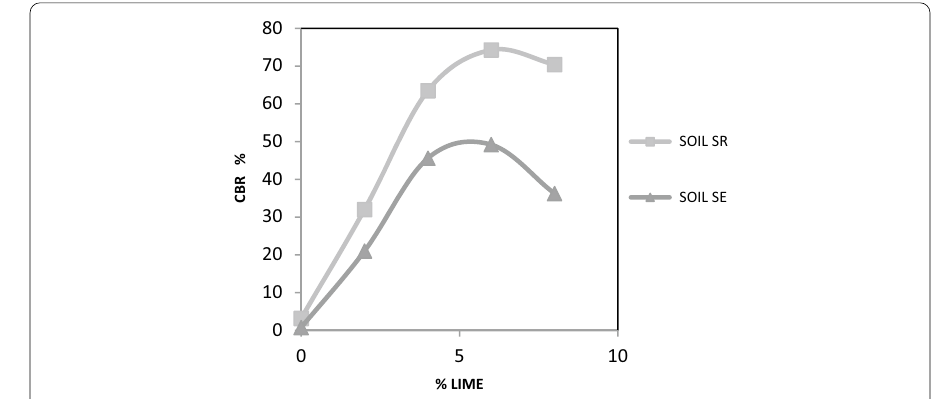
reactions—(i) cation exchange and flocculation-agglomeration (ii) Pozzolonic reac-